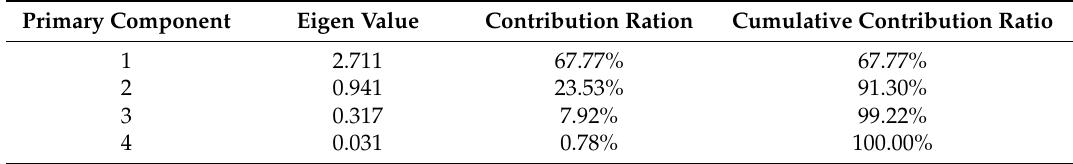
Table 3. Eigenvalues, contribution ratio, and cumulative contribution ratio of principal components 1 to